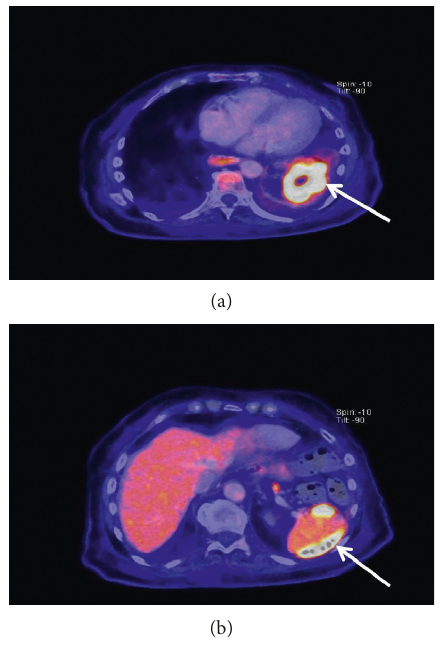
Figure 1: (a) Transesophageal echocardiography with a corner of 0 ° . Endocarditis vegetation of mitral valve is marked with arrow. (b) Transesophageal echocardiography with a corner of 90 ° . Endo- carditis vegetation of mitral valve is marked with arrow.